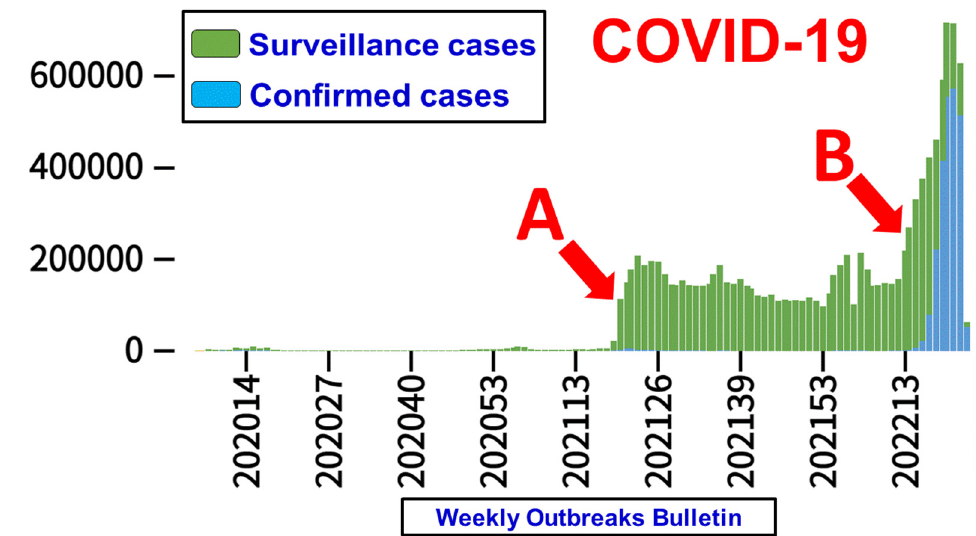
Figure 1. Surveillance data of COVID-19 in Taiwan. Two un-expected hits of this disease in Taiwan were noticed. (Time point A ) The first hit occurred in May 2021 and was caused by the Alpha variant. There were 37,710 confirmed cases and 854 deaths; (Time point B ) the second hit started in April 2022 caused by the Omicron variant (Data modified from the press release by the Taiwan Centers for Disease Control, https://www.cdc.gov.tw/En; accessed on 6 June 2022).